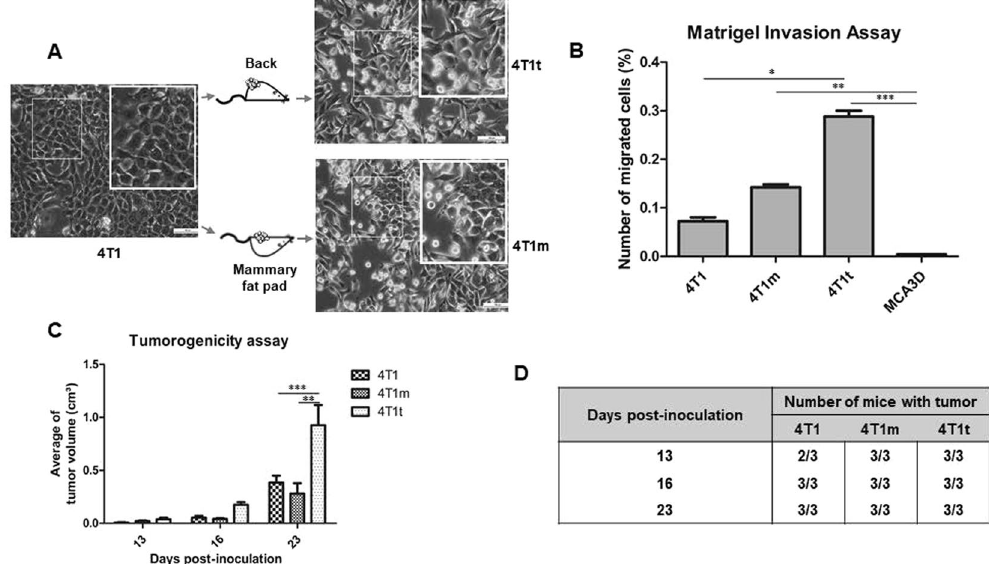
Figure 2. Cell lines derived from 4T1-induced tumors are more malignant. ( A ) Origin and phase contrast micrographs of 4T1t and 4T1m cell lines. Bars, 100 μ m. Insets show increased magnifications of the indicated areas. ( B ) Matrigel invasion assay. Cells were seeded on a 24-well Matrigel-coated invasion chamber. FBS (5%) was used as a chemoattractant. Migrated cells on the underside of the filter were fixed, stained and counted. Values are the percentage of migrated cells with respect to the total cells seeded on the well, and represent the means of triplicate assays from three independent experiments. Asterisks indicate statistically significant difference ( * p < 0.05; ** p < 0.01; *** p < 0.001) ( C ) Tumorigenic behavior of 4T1-derived cell lines. Groups of mice (n = 3) were inoculated i.d./s.c. with 10 3 cells into the left flank. The size of tumors was measured at the indicated times with a caliper and the volume calculated as indicated in Materials and Methods. Asterisks indicate statistically significant difference ( ** p < 0.01; *** p < 0.001). ( D ) The incidence of tumors at different indicated post-injection